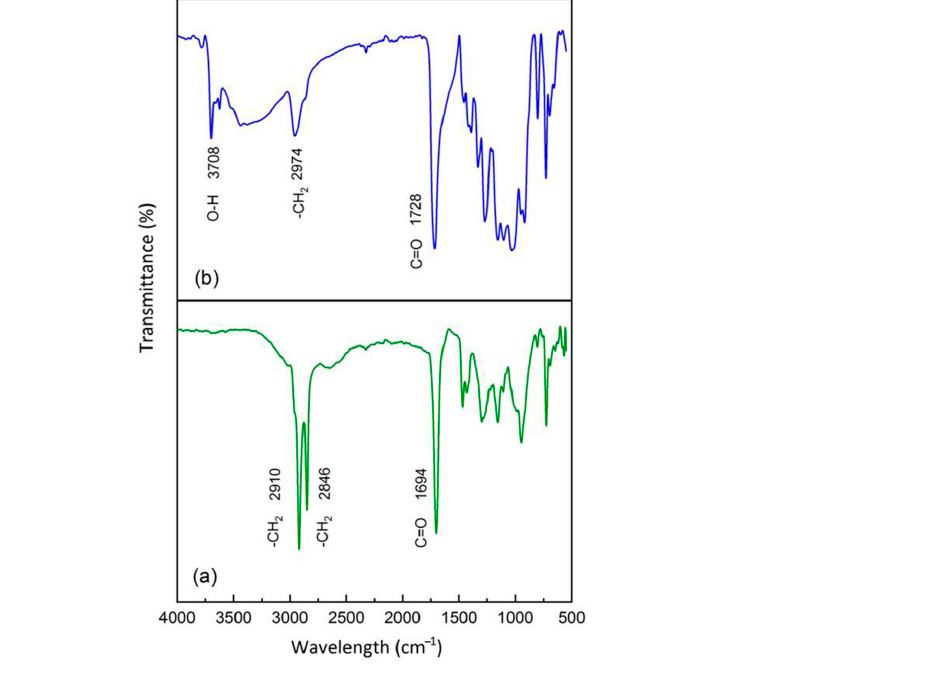
Figure 10. FT-IR spectra of the PBS/PBAT/TPS composites ( a ) TPS36/24 before degradation, ( b ) TPS36/24 after degradation with changes in the functional group.